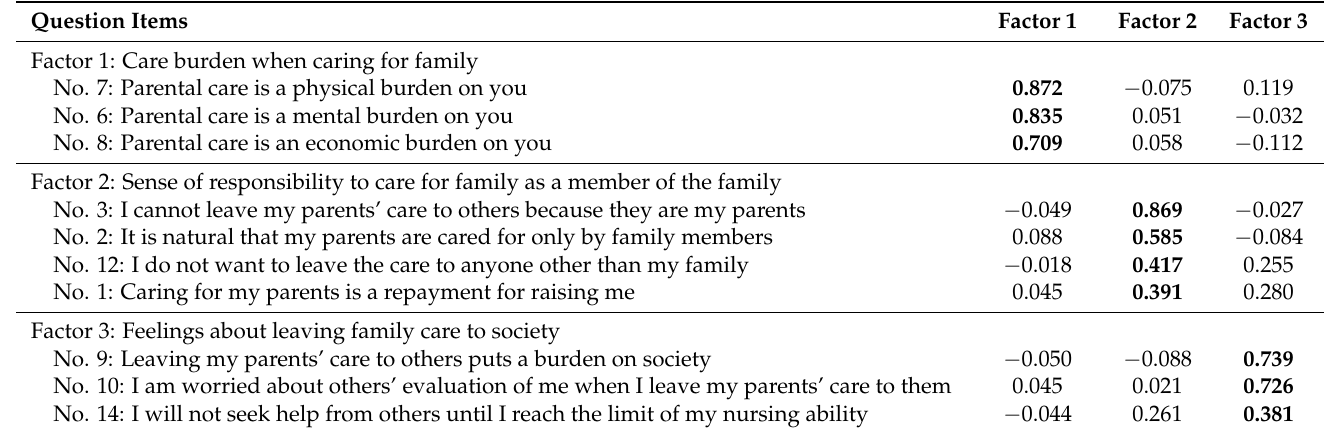
Table 2. Exploratory factor analysis of the awareness of long-term care socialization.